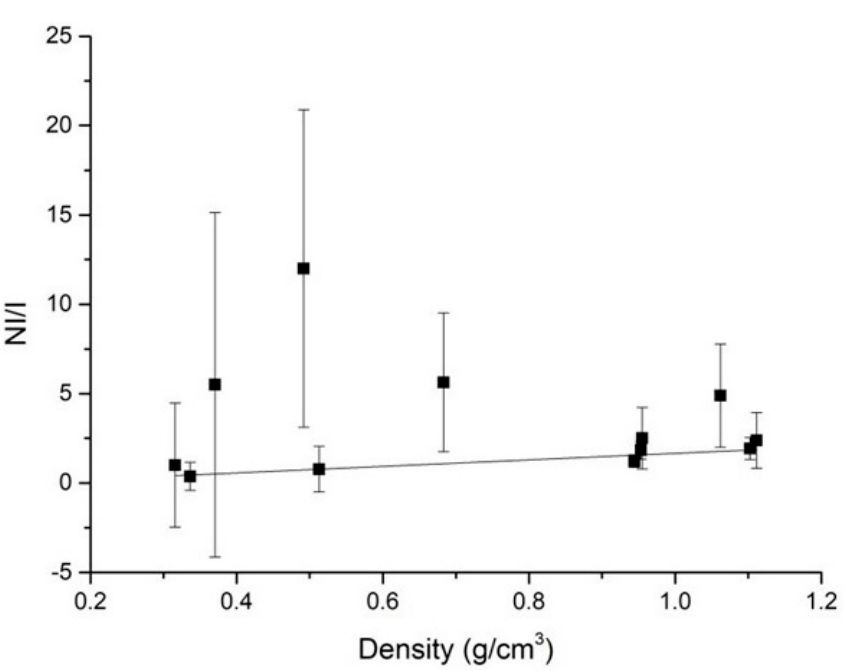
Figure 4. Plot of the ratio between bone-density values measured without irrigation (NI) and under irrigation (I) versus the actual density of the equine bone blocks.